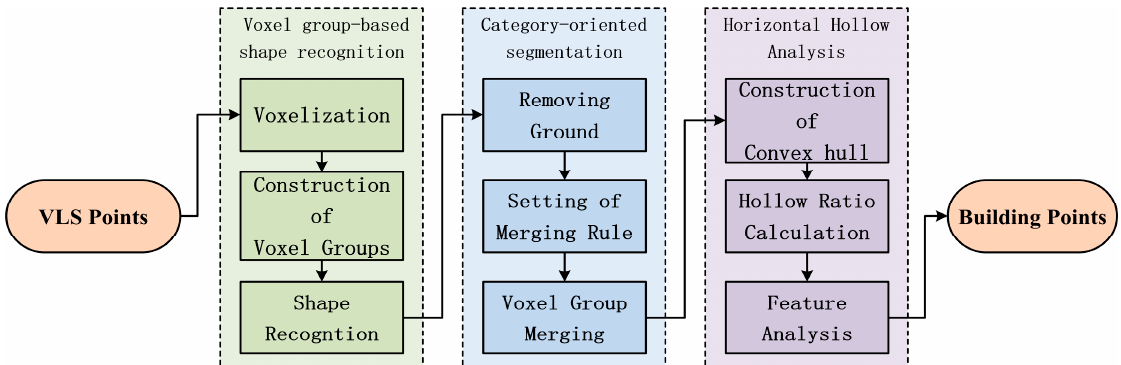
Figure 1. Flowchart of building point extraction from VLS point data.